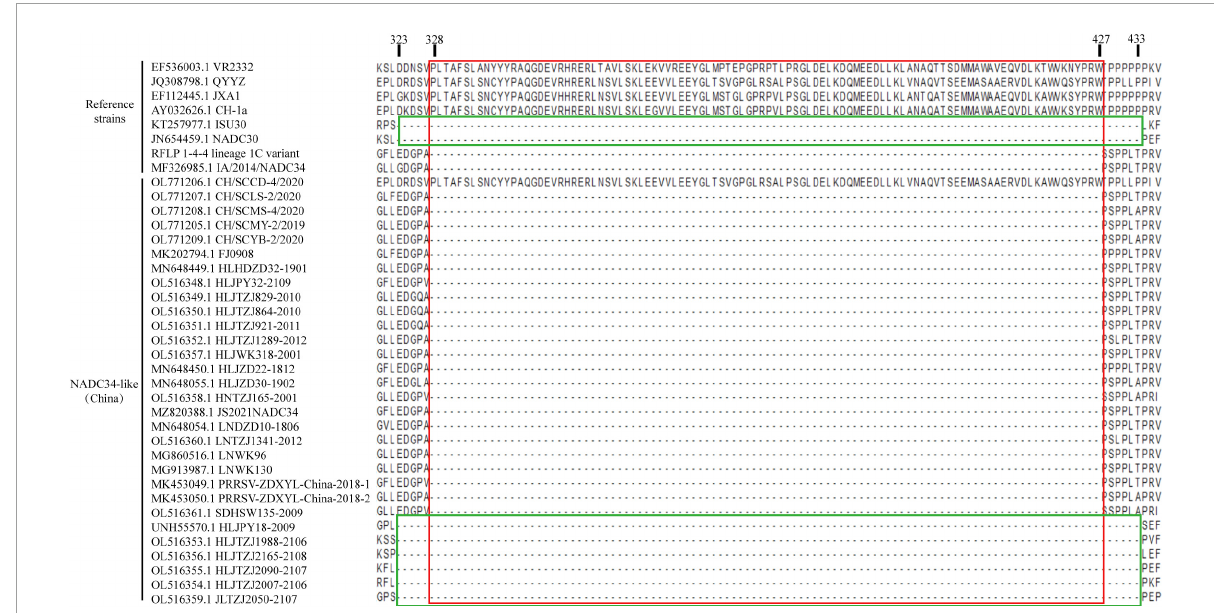
FIGURE3 Alignment of Nsp2 amino acid sequences. Most of the NADC34-like strains isolated in China have a continuous deletion of 100 aa, which corresponds to positions 348–427 in Nsp2 from the reference strain VR2332 (boxed in red). The strains that recombine at the Nsp2 position differ (boxed in green). Amino acids were aligned using the MegAlign tool in Lasergene software (DNASTAR Inc., Madison, WI, United